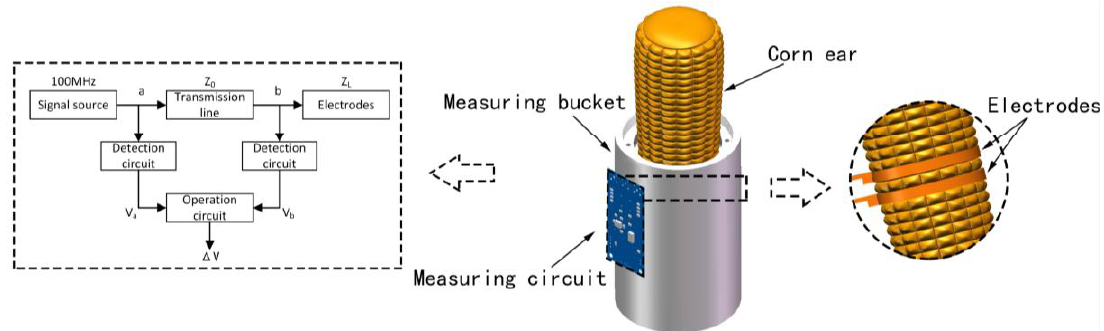
Figure 2. Corn ear moisture measurement sensor structure, including circuit and electrodes.